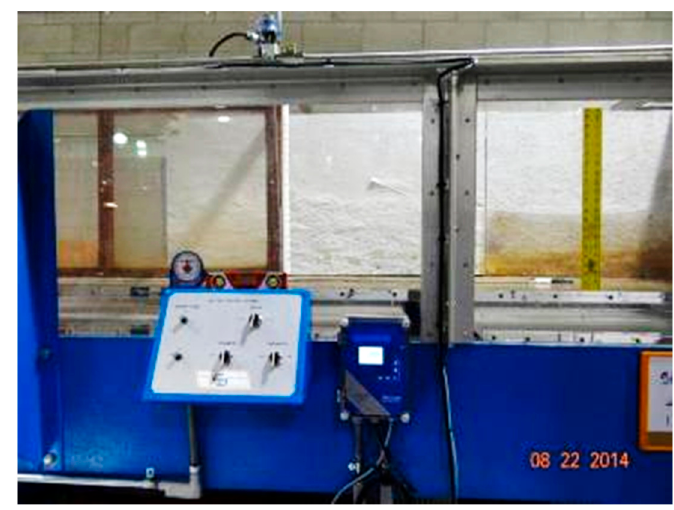
Figure 6. Greyline AVFM 5.0 installed on the flume. Figure 7. Greyline AVFM 5.0 installed on the flume.